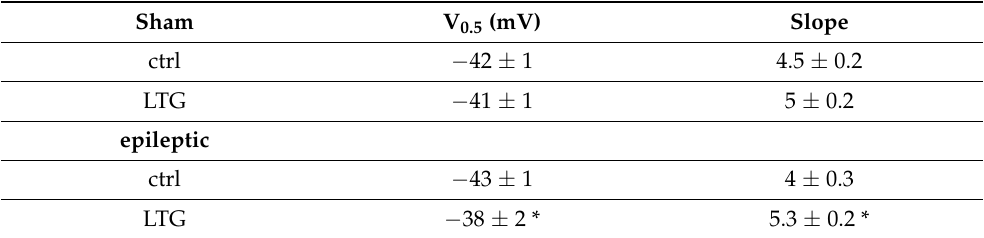
Table 1. Na + channel activation parameters for control conditions and during exposure to 10 µ mol/L of LTG. Tukey test using one-way ANOVA (ctrl vs. LTG), * indicates p <